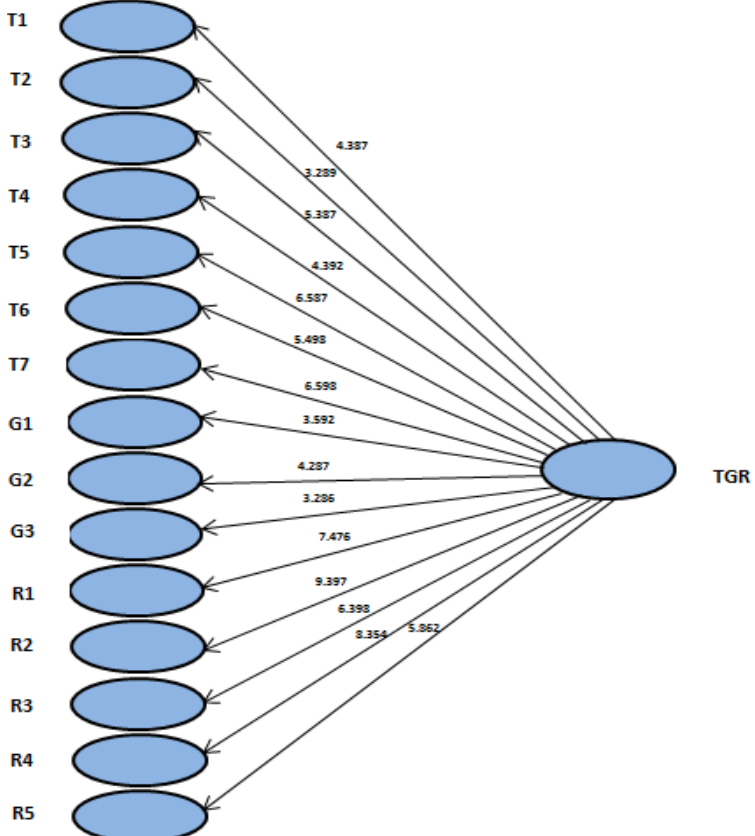
Fig. 3. Values of the